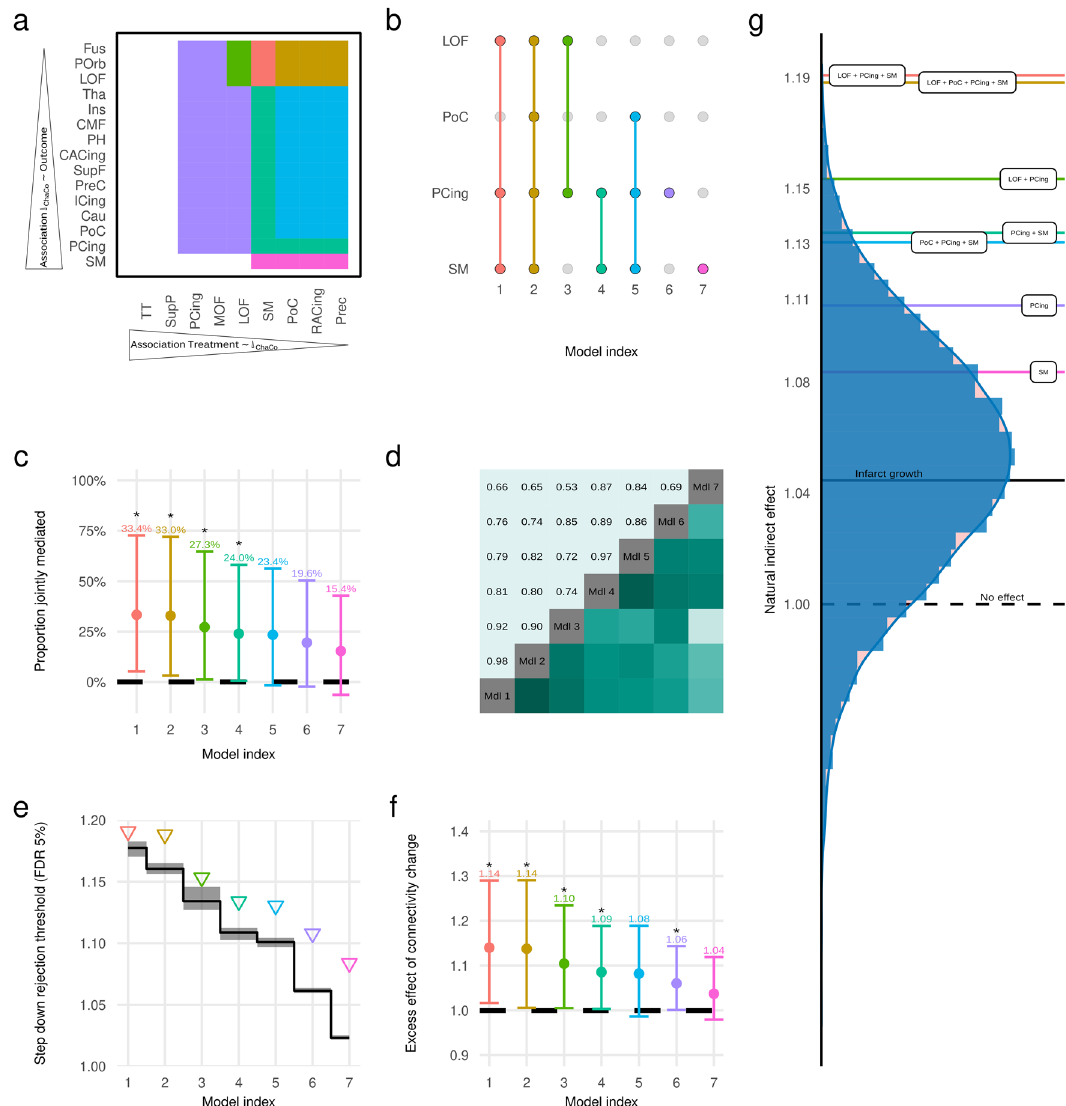
Fig. 4 Results of multiple mediation analysis, adjusted for age, baseline NIHSS score and pre-randomization lesion volume. a Selection of brain regions by decreasing strength of association between treatment allocation and connectivity change (horizontal axis) and connectivity change and functional outcome (vertical axis). Each colored patch corresponds to a mediation model including, as mediators, infarct growth as well as connectivity change in the intersection of the i most alteplase-responsive (horizontal axis) and j most clinically eloquent (vertical axis) regions. Identical color coding is applied for the following subgraphs ( b , c , e – g ) to identify underlying referred models. b Composition of resulting seven mediation models comprising connectivity change in up to four brain regions. c Proportion of total effect of thrombolysis on favorable clinical outcome (mRS 0 – 1) mediated jointly through infarct growth and connectivity change in different sets of brain regions ( n = 263 independent subjects). Solid dots represent point estimates. Vertical bars indicate 95% bias- corrected con fi dence intervals obtained from bootstrap with k = 10,000 replicates, stars (*) highlight models in which the 95%-CI does not contain 0%. d Empirical correlation between natural indirect effect estimates corresponding to different mediation models. Darker shades of green correspond to stronger correlations as indicated numerically in the left upper triangle of the matrix. e Step-down procedure to control the false discovery rate in the joint assessment of multiple mediation models at 5%. Models are ordered by their empirical natural indirect effect, indicated by triangles; beginning with the strongest effect, null hypotheses of no mediation effect are sequentially rejected as long as NIEs exceed their respective rejection threshold indicated by the black step line (median of k = 100 bootstrap replicates). Shading indicates 95% con fi dence intervals for the rejection line. f Point estimates (solid dots) and 95% con fi dence intervals (vertical bars) for the ratio between joint natural indirect effects of infarct growth and connectivity loss and the NIE of infarct growth alone (bootstrap with k = 10,000 replicates; n = 263 independent subjects). g Null distribution of empirical natural indirect effects mediated jointly through infarct growth and connectivity change in random subsets of all brain regions. Horizontal lines indicate the mediation effects of infarct growth alone (black, NIE 1.04) and infarct growth in combination with connectivity change in alteplase-responsive clinically eloquent areas (colored). NIE Natural indirect effect, SM supramarginal, PCing posterior cingulate, PoC postcentral, Cau caudate, ICing isthmus cingulate, PreC precentral, SupF superiorfrontal, CACing caudal anterior cingulate, PH parahippocampal, CMF caudal middle frontal, Ins insula, Tha thalamus, LOF lateral orbitofrontal, POrb pars orbitalis, Fus fusiform, TT transverse temporal, SupP superior parietal, MOF middle orbitofrontal, RACing rostral anterior cingulate.